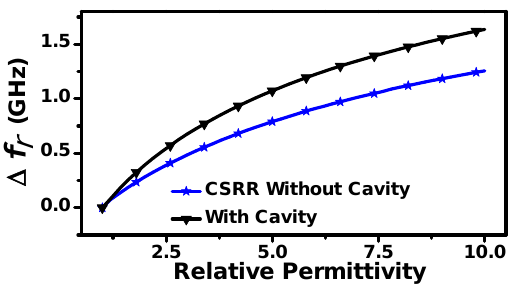
Figure 5. The sensitivity of a single CSRR (shift in the resonance frequency) versus relative permittivity of a dielectric slab with a thickness of 3 mm, with and without a cavity. The relative permittivity of a dielectric slab is varied from 1 to 10 with an increment of